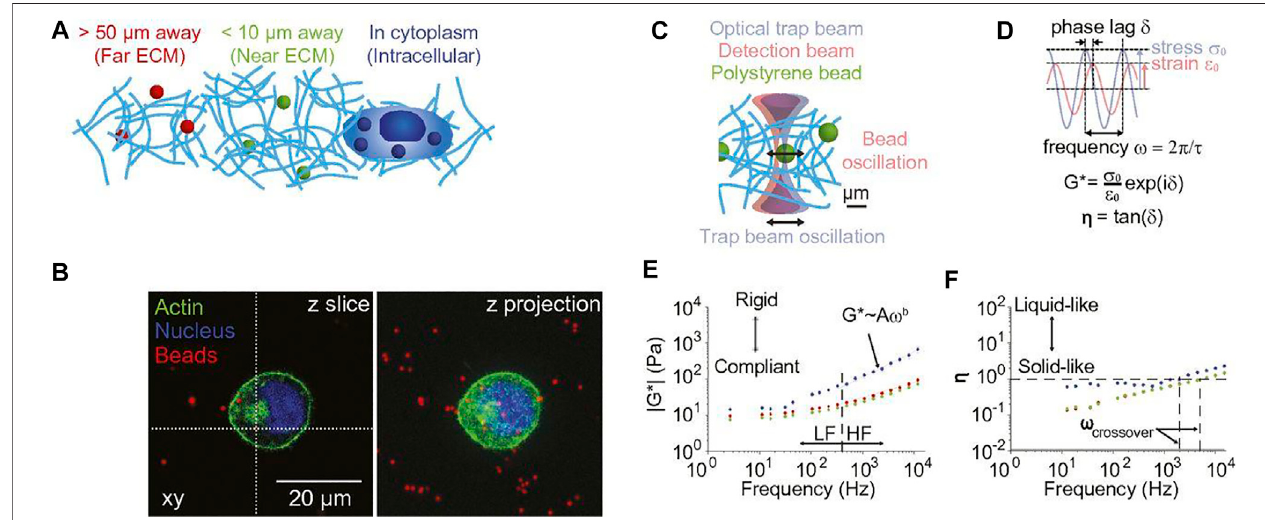
FIGURE 7 | Active microrheology using optical tweezers inside cells and in the extracellular matrix (ECM) near and far from the cell. (A) Illustration of one micron particlesprobing inside thecells and intheECM. (B) Confocal images showingthedistributionofparticles(red). (C) Illustrationofoscillatingaprobebythe optical trap in the medium. (D) Dynamic parameters obtained from the optical trapping measurement. (E) Frequency dependent complex modulus shows power law dependence in the high frequency regime. (F) Hysteresivity ( η = G ″ /G ′ ) shows the liquid-like or solid-like dominating property of the material. Figure from J. R. Staunton, W. Y.